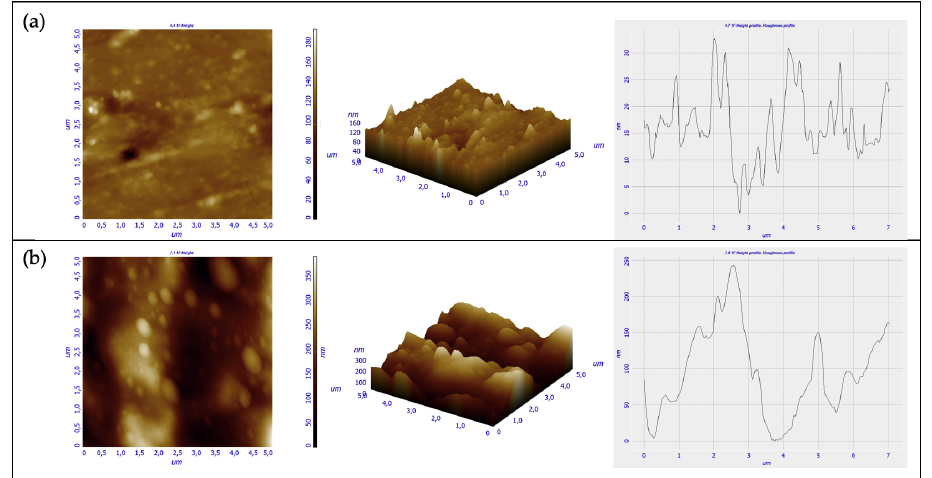
Figure 13. Measurements conducted from the side view in both VeroClear RGD 810 ( a ) and NOA88 ( b